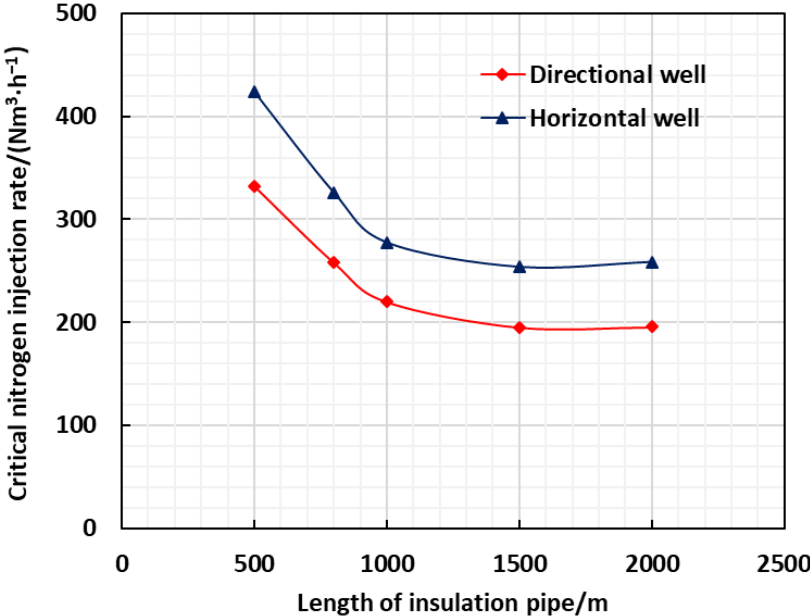
Figure 6. Relationship between heat insulation pipe length and critical nitrogen injection displacement.